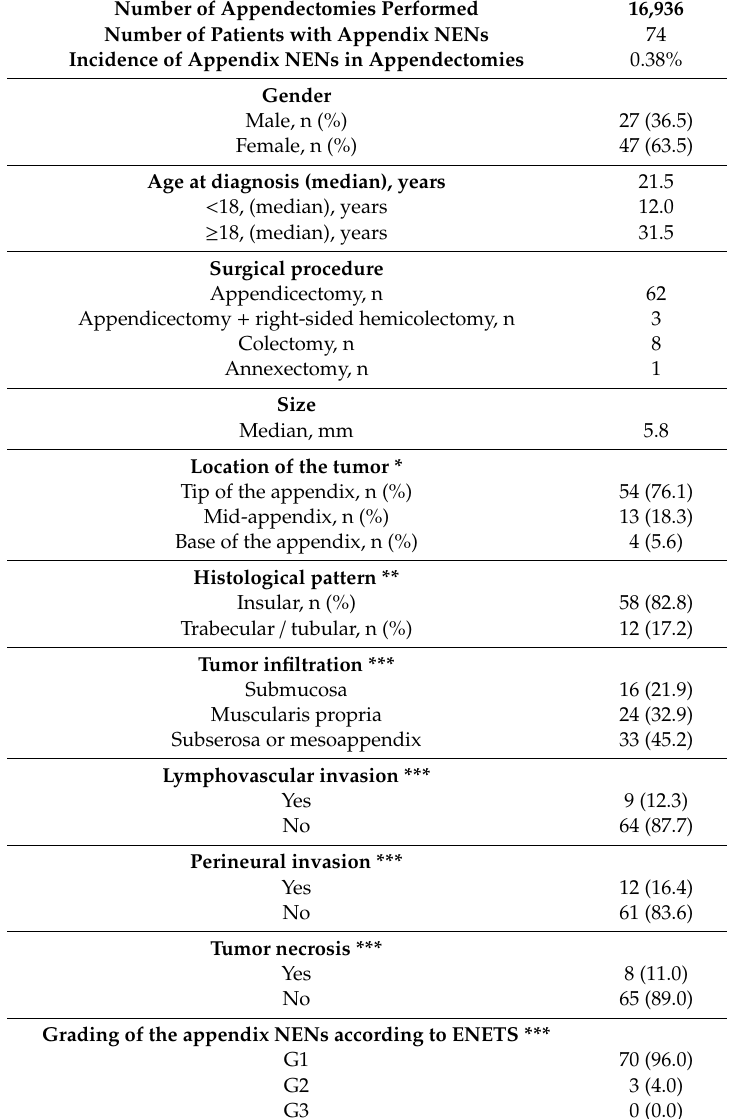
Table 1. Clinicopathological data of the appendiceal neuroendocrine neoplasms (NENs). Number of Appendectomies